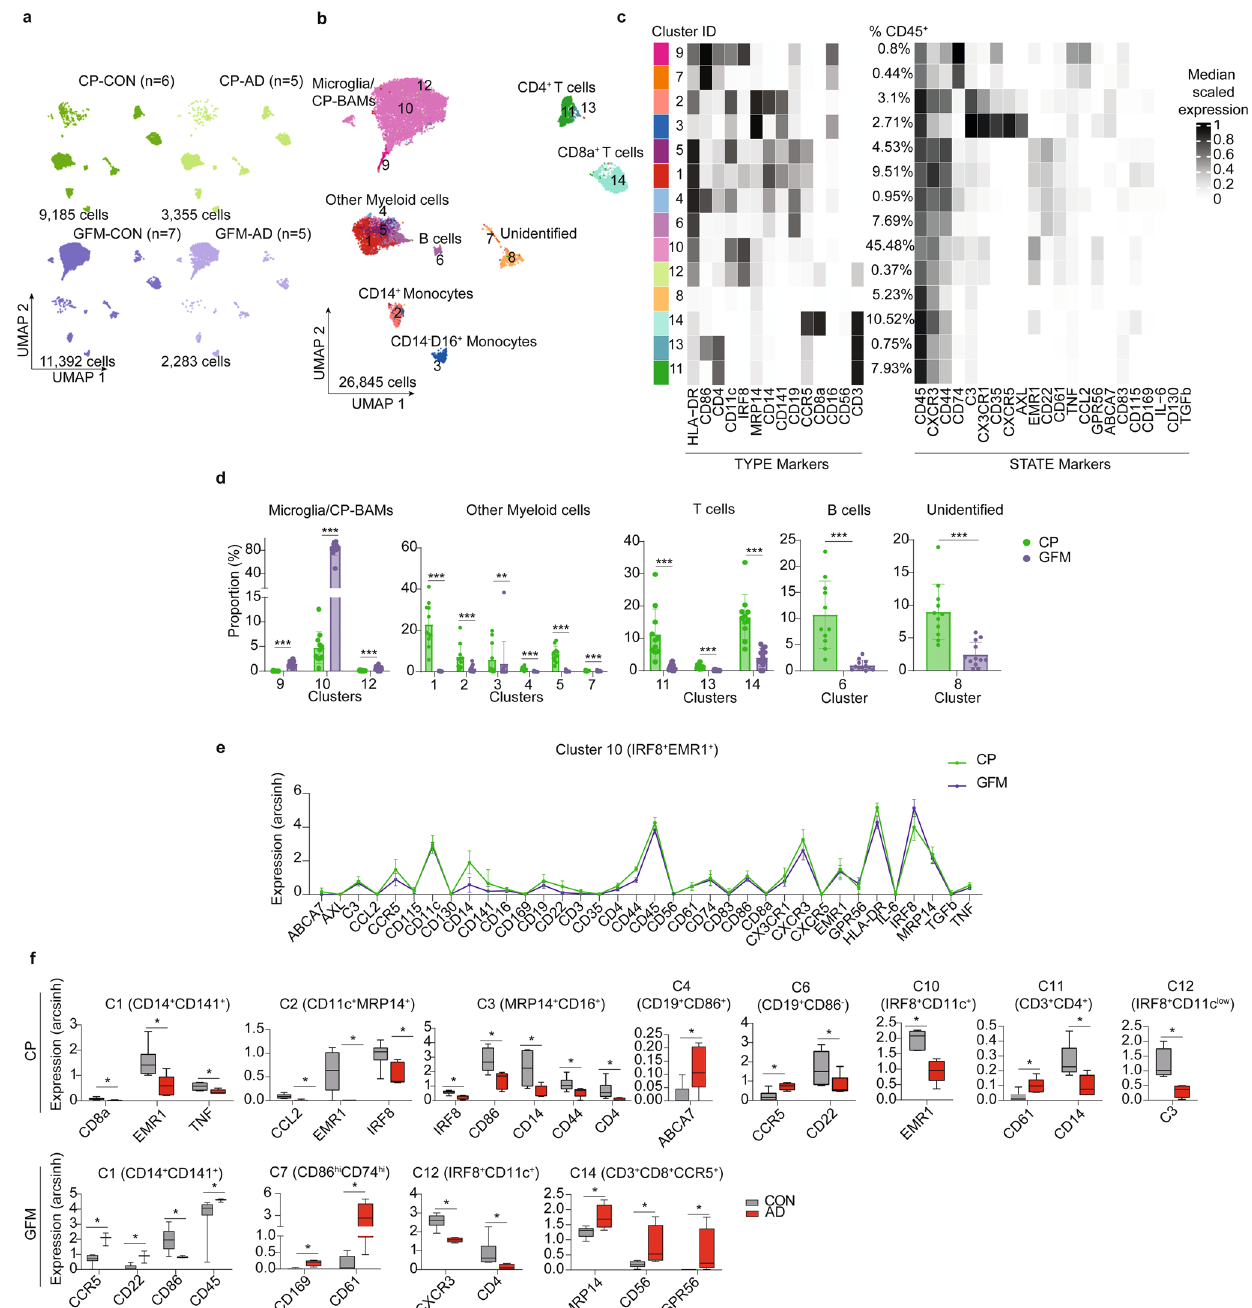
Fig. 7 | Differential heterogeneity of CD45 + immune cells in CP and GFM of AD donors, compared to the CON donors, determined by using Panel A (CP: CON, n =7; AD, n =4, GFM: CON, n =7; AD, n =5, biological replication). a Overlaid UMAP plots of CP and GFM samples from AD (green dots) and CON (purple dots) donors. b UMAP plots of all samples. The colouring indicates 14 clusters repre- senting diverse immune cell phenotypes, de fi ned by the FlowSOM algorithm. c Phenotypic heatmap of cluster identities depicting the expression levels of 14 TYPE markers used for the cluster analysis and 22 STATE markers. Heat colours of expression levels have been scaled for each marker individually (to the 1st and 5th quintiles) (black, high expression; white, no expression). d The bar graphs show